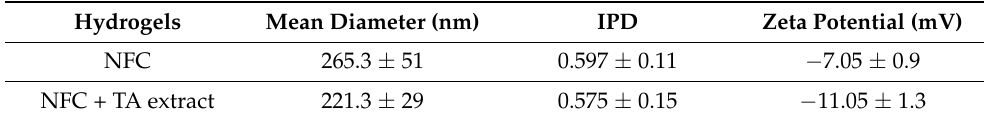
Table 2. Particle diameter, polydispersity index (IPD), and zeta potential of the NFC-based